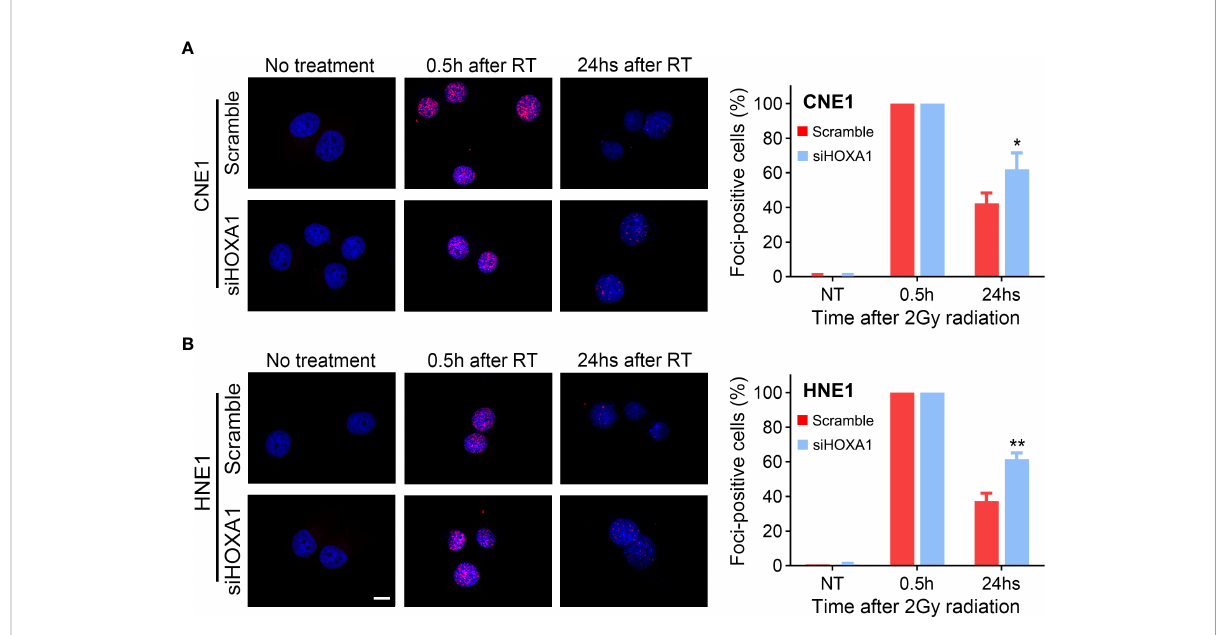
FIGURE 6 HOXA1 affected DNA repair capacity of NPC cells. enhanced the radioresistance of NPC cells. Immuno fl uorescence staining for g H2AX indicated that HOXA1 knockdown delayed absorption of g H2AX foci induced by 2Gy irradiation in CNE1 (A) and HNE1 cells (B) . (B) Cumulative bar chart showing that high HOXA1 expression was correlated with high risk of local relapse in NPC patients. Representative immuno fl uorescence images and quanti fi cation of the percentage of g H2AX foci-positive cells were shown. A positive cell was de fi ned by the presence of more than 10 g H2AX foci. Scale bars, 10 m m. * P < 0.05, ** P <